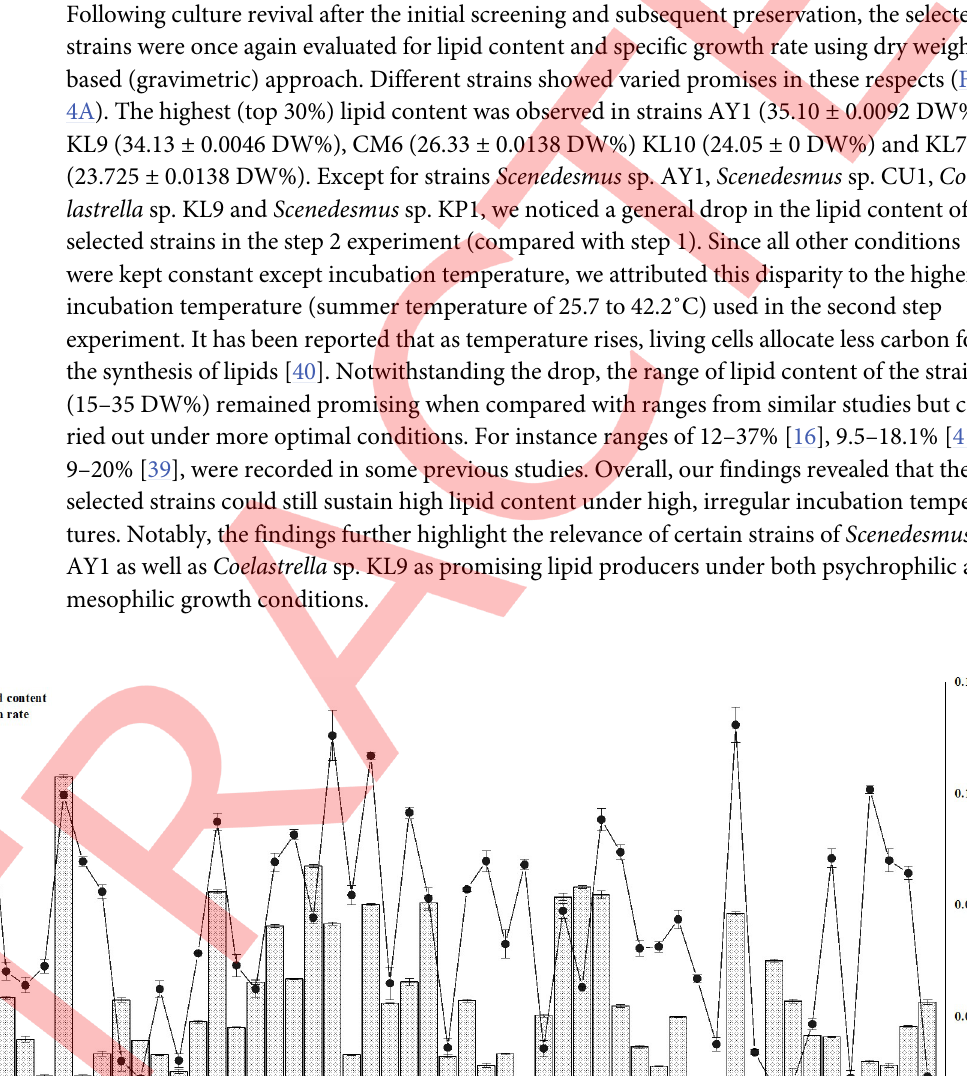
Fig 1. Light microscope images of some microalgae strains, used in this work. (A) Scenedesmus sp. HN2, (B) Pseudospongiococcum sp. AY4, (C) Coelastrella sp. CM2, (D) Scenedesmus sp. AY1, (E) Desmodesmus sp. KL10, (F) Coelastrum sp. CM6, (G) Coelastrum sp. CU1, (H) Coelastrella sp. HN1.